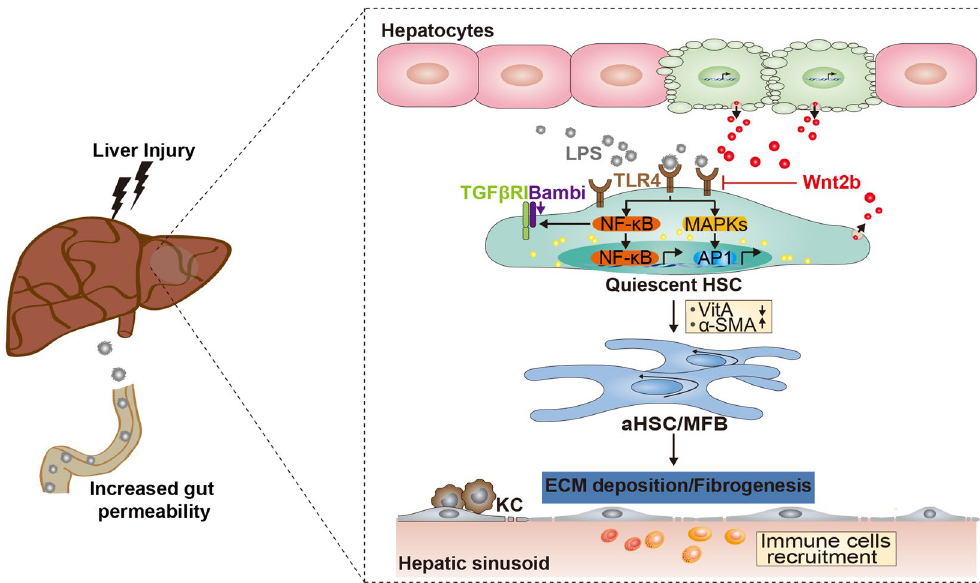
Figure 7. A schematic model for the inhibitory effects of Wnt2b on HSCs activation and liver fibrosis through negative regulating TLR4